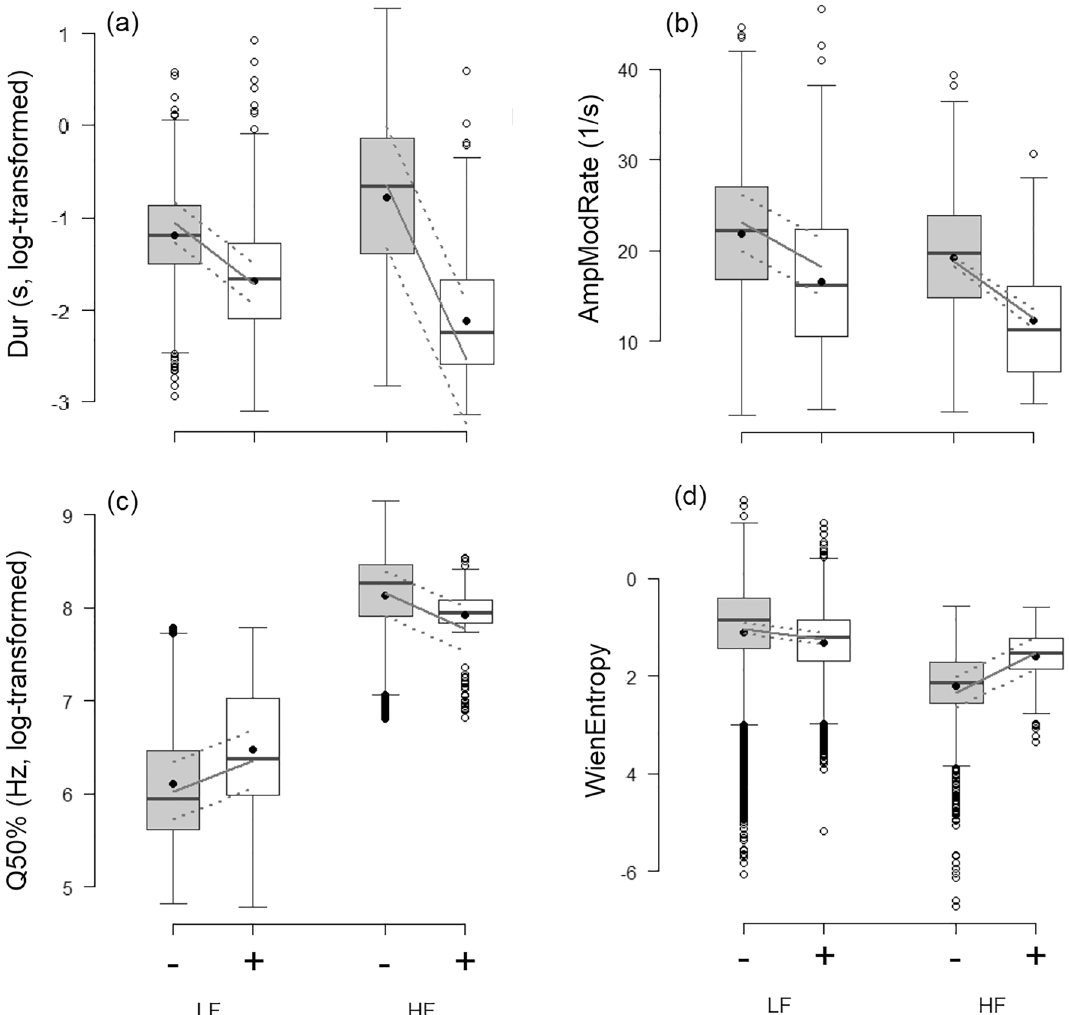
the valence (“ − ” = negative (grey); “ + ” = positive (white)) and call type (“LF” = low-frequency calls; “HF” = high- frequency calls). Boxplots: the horizontal line shows the median, the box extends from the lower to the upper quartile and the whiskers to 1.5 times the interquartile range above the upper quartile or below the lower quartile, and open circles indicate outliers and black circles the mean; the grey lines show the model estimates (continuous line) and 95% confidence intervals (dashed lines). All comparisons between negative and positive valence, for each call type, were significant (LMM: p ≤